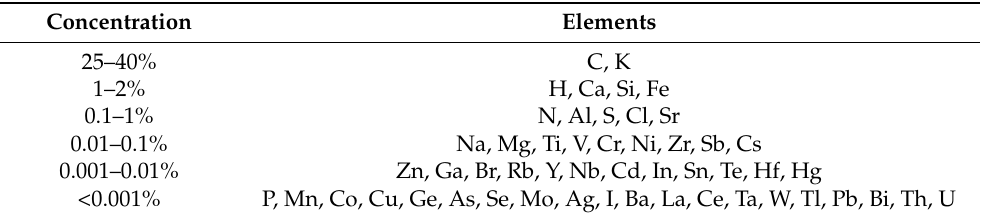
Table 1. Proximate elemental composition (%) of tested Siberian leonardite. Concentration